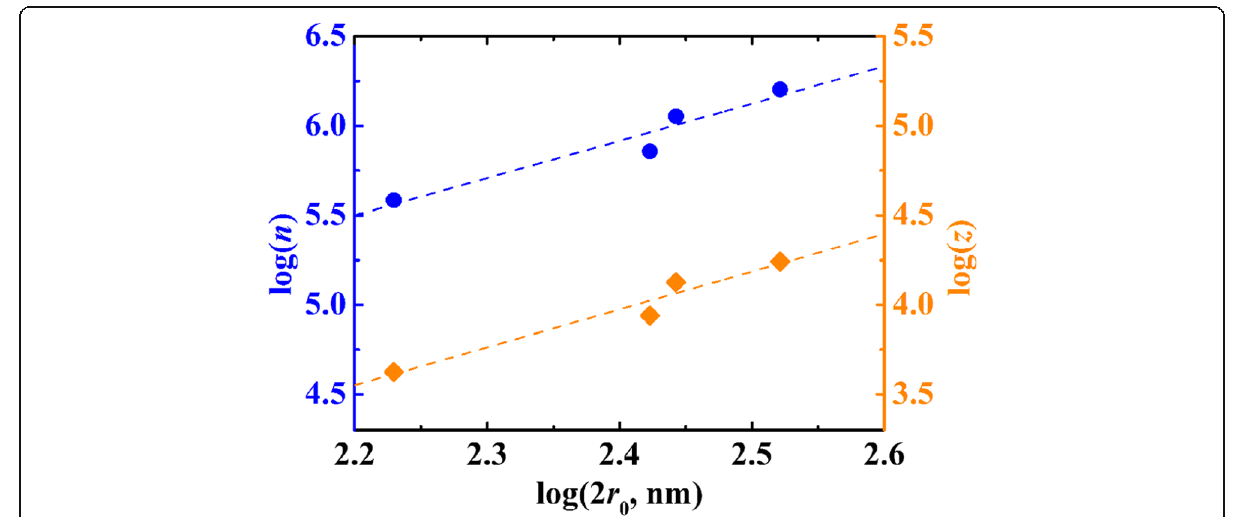
Fig. 2 Logarithmic plots of the number of − COOH and − COO + per particle against the diameters of PSA spheres